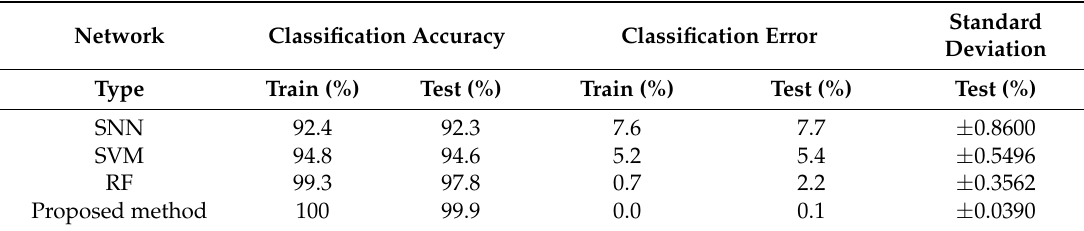
Table 12. Average classification accuracy of different methods after k = 4 experiments. Their corresponding standard deviations are also